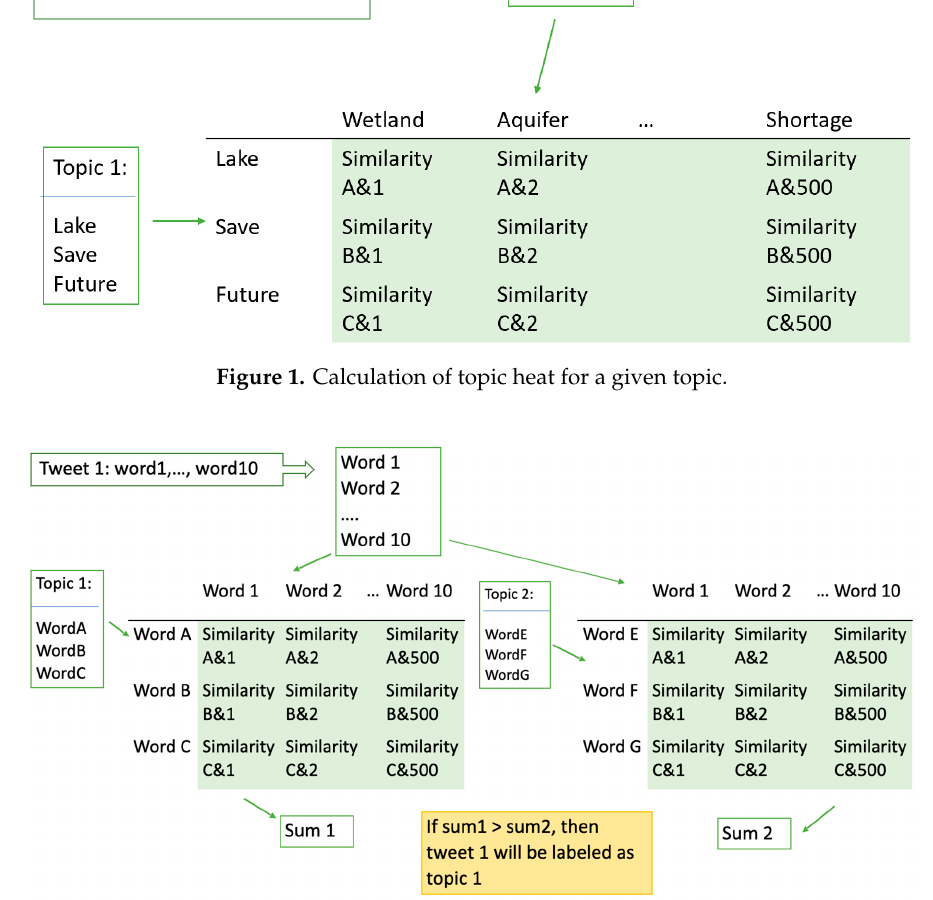
Figure 2. Process of categorizing tweets under topics using topic heat.